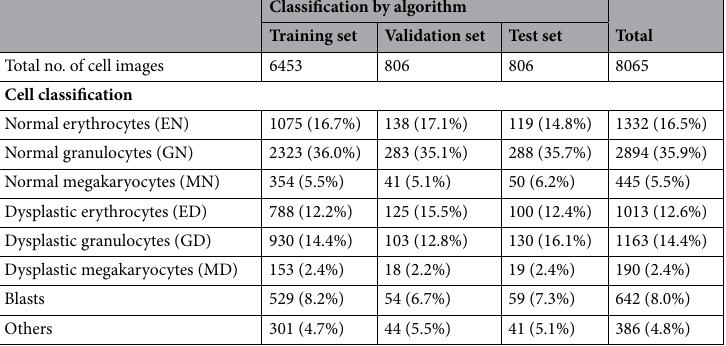
Table 2. Number of cell images used in the study.